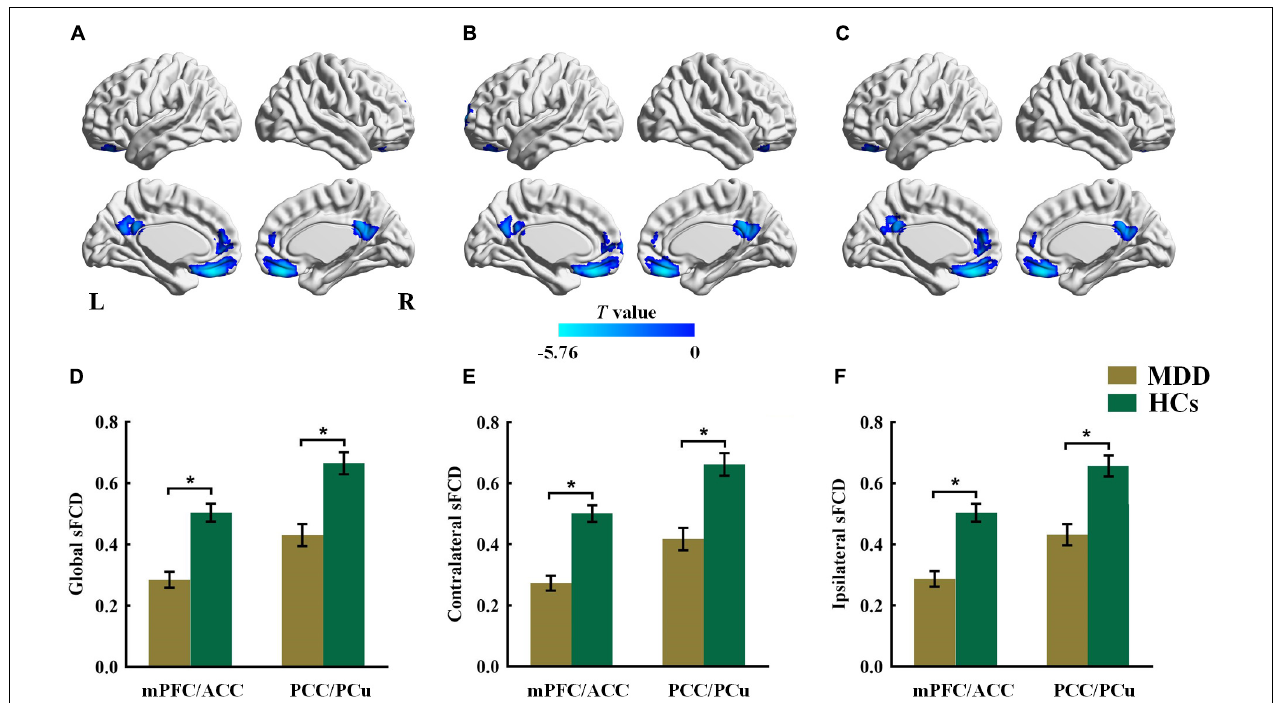
FIGURE 2 | The group difference for (A) global, (B) contralateral and (C) ipsilateral sFCD between the MDD and HCs groups. The color bars indicate the T value based on two-sample t -test. The statistical significance level was set at P voxel < 0.005, P cluster < 0.05 under Gaussian random field theory (GRF) corrected. The histogram shows the average (D) global, (E) contralateral and (F) ipsilateral sFCD values in the mPFC/ACC and PCC/PCu. * p < 0.05. These results are mean ± standard error. Abbreviations: sFCD, static functional connectivity density; mPFC, medial prefrontal cortex; ACC, anterior cingulate cortex; PCC, posterior cingulate cortex; PCu, precuneus; MDD, major depressive disorder; HCs, healthy controls; L, left; R, right.